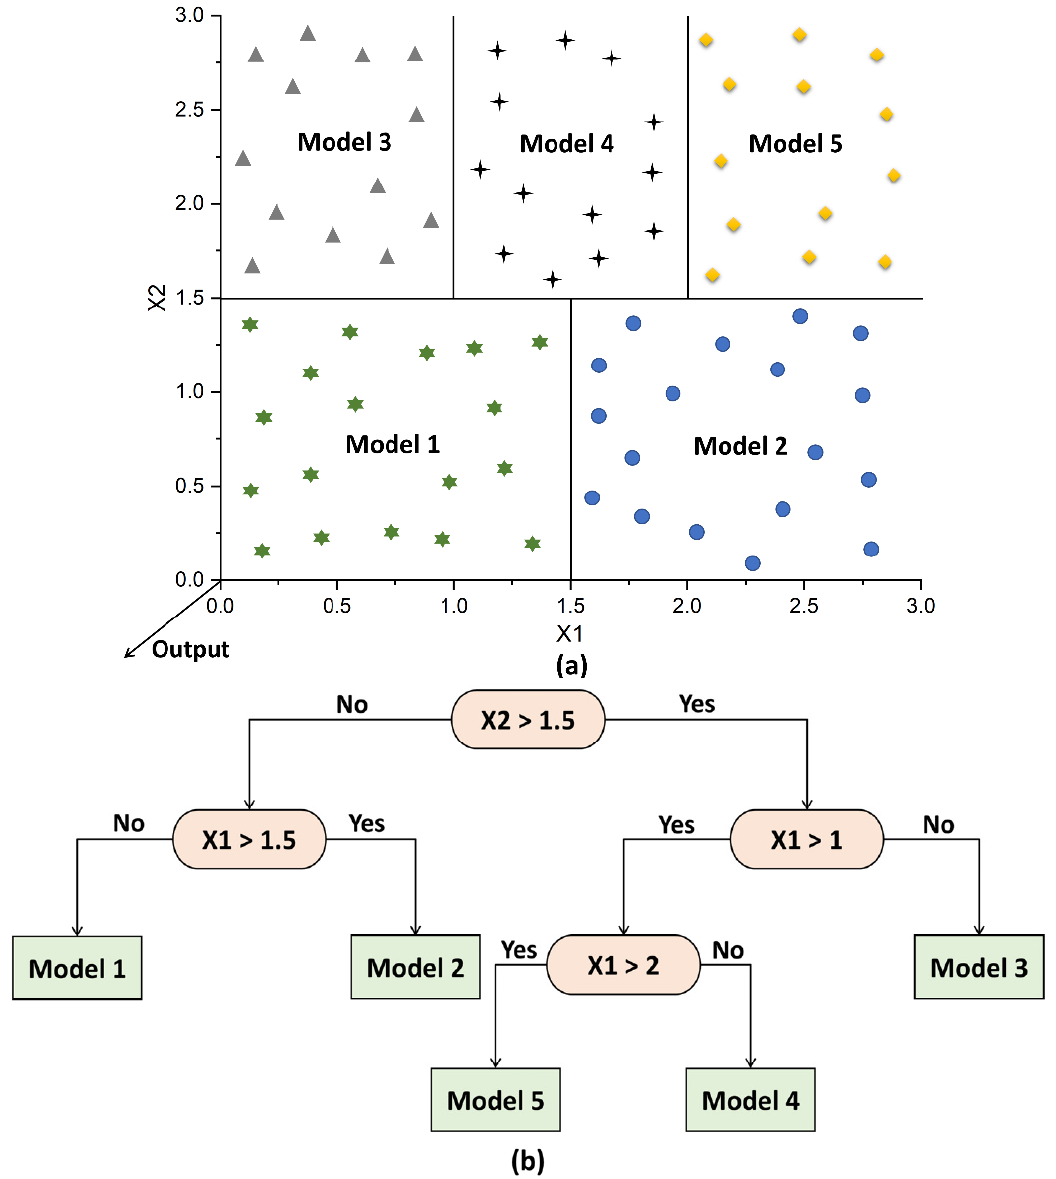
Figure 4. Illustration of M5 algorithm: ( a ) splitting of input space; ( b ) building of tree. The input space is initially partitioned into a tree-like structure of different